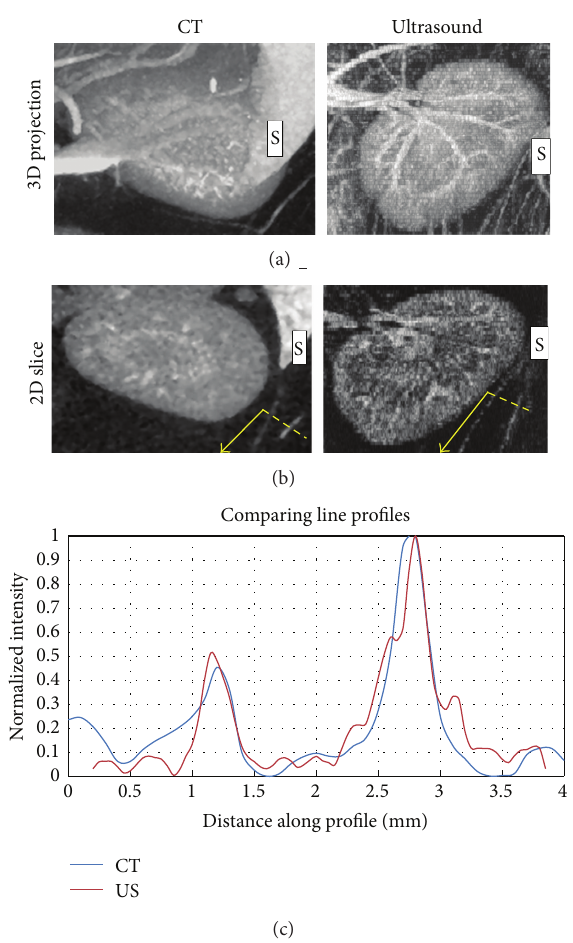
Figure 8: A comparison between the CT and ultrasound images acquired of the same kidney. The slight anatomical warping due to ultrasound probe contact with tissue resulted in a lack of direct one- to-one visual correspondence between the two 3D images, though the same anatomy is contained within each image. (a) Maximum intensity projections of image data. The spleen is visible in each of these images to the right of kidney (indicated with an “S”). (b) En face cuts through the 3D image. (c) Line profiles (dashed yellow lines) across two corresponding vessels near the spleen (dashed yellow lines) suggest similar feature